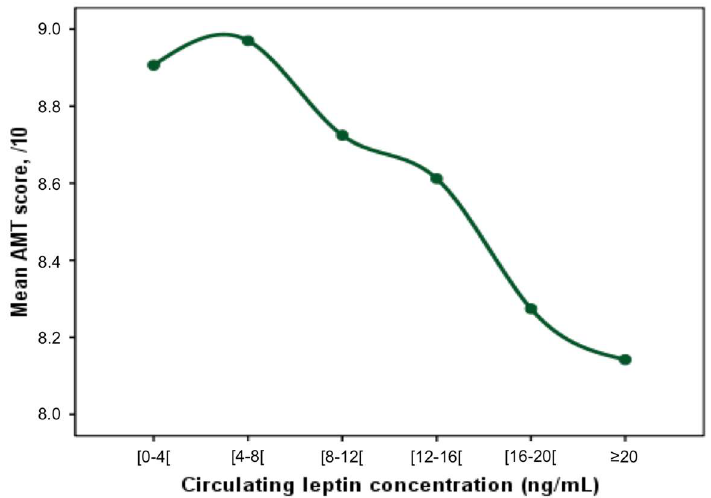
Figure 1. Mean Abbreviated Mental Test score (/10) according to the circulating leptin concentration (ng/mL).